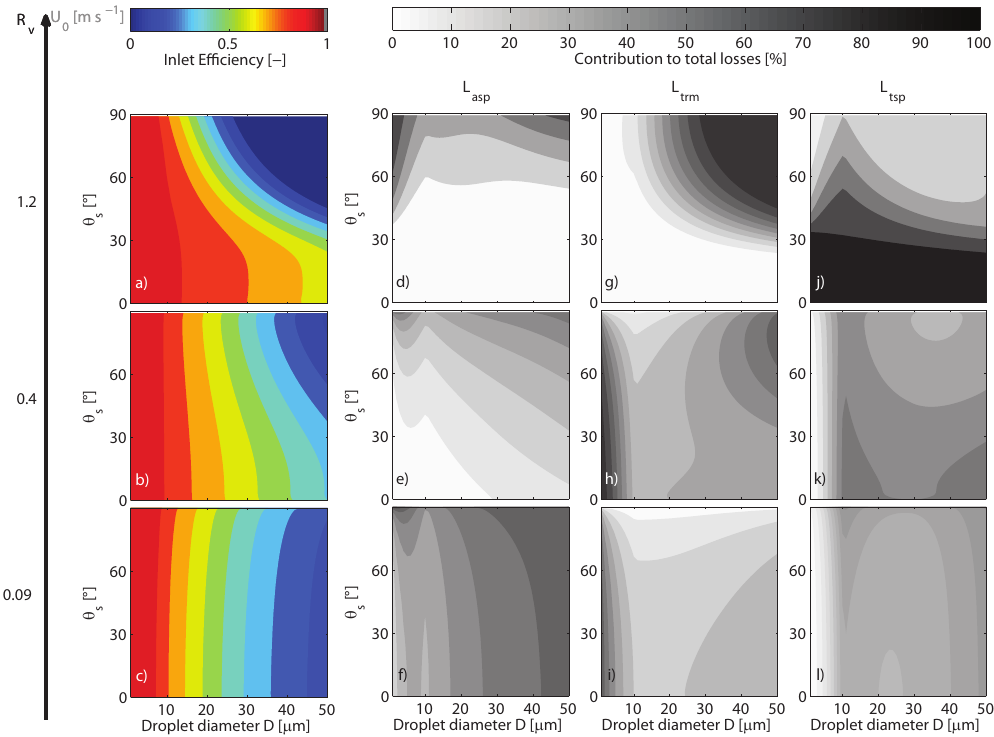
Fig. 8. (a) to (c) Total inlet efficiencies as a function of sampling angle θ s versus droplet diameter D for three different representative velocities ( R v =1.2, 0.4 and 0.09) of each velocity range. The individual percentaged contributions of aspiration losses (d) to (f) , transmission losses (g) to (i) and transport losses (j) to (l) are shown as percentaged values (see black and white color bar).